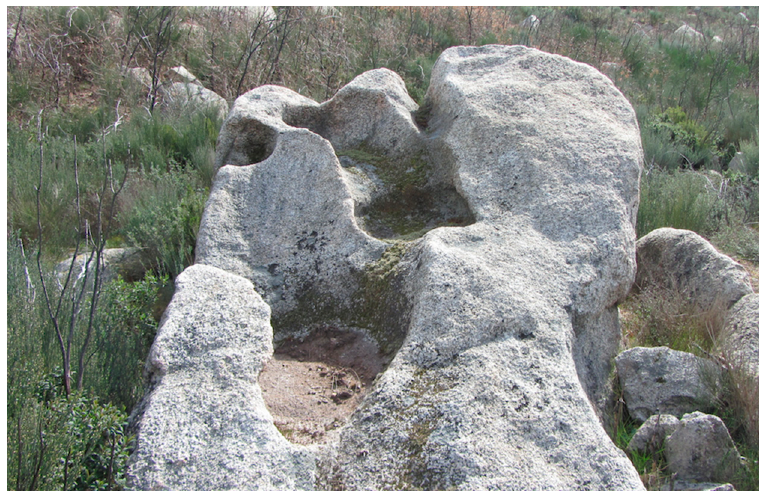
Figure 4. Example of a complex form of sinks and tafone outlines in leucocrate granite and coarse-grained porphyritic with the presence of feldspar megacrystals—eastern slopes of Serra do Alvão. It is present in granitic areas, takes on different names, and varies according to the language and the area of the globe. This may be defined as cavities or bowls as rock excavated in the solid rock bed, generally circular, oval, or elliptical [30]. They are shapes that allow the retention of water, which usually disappears through evaporation (Figure 5).